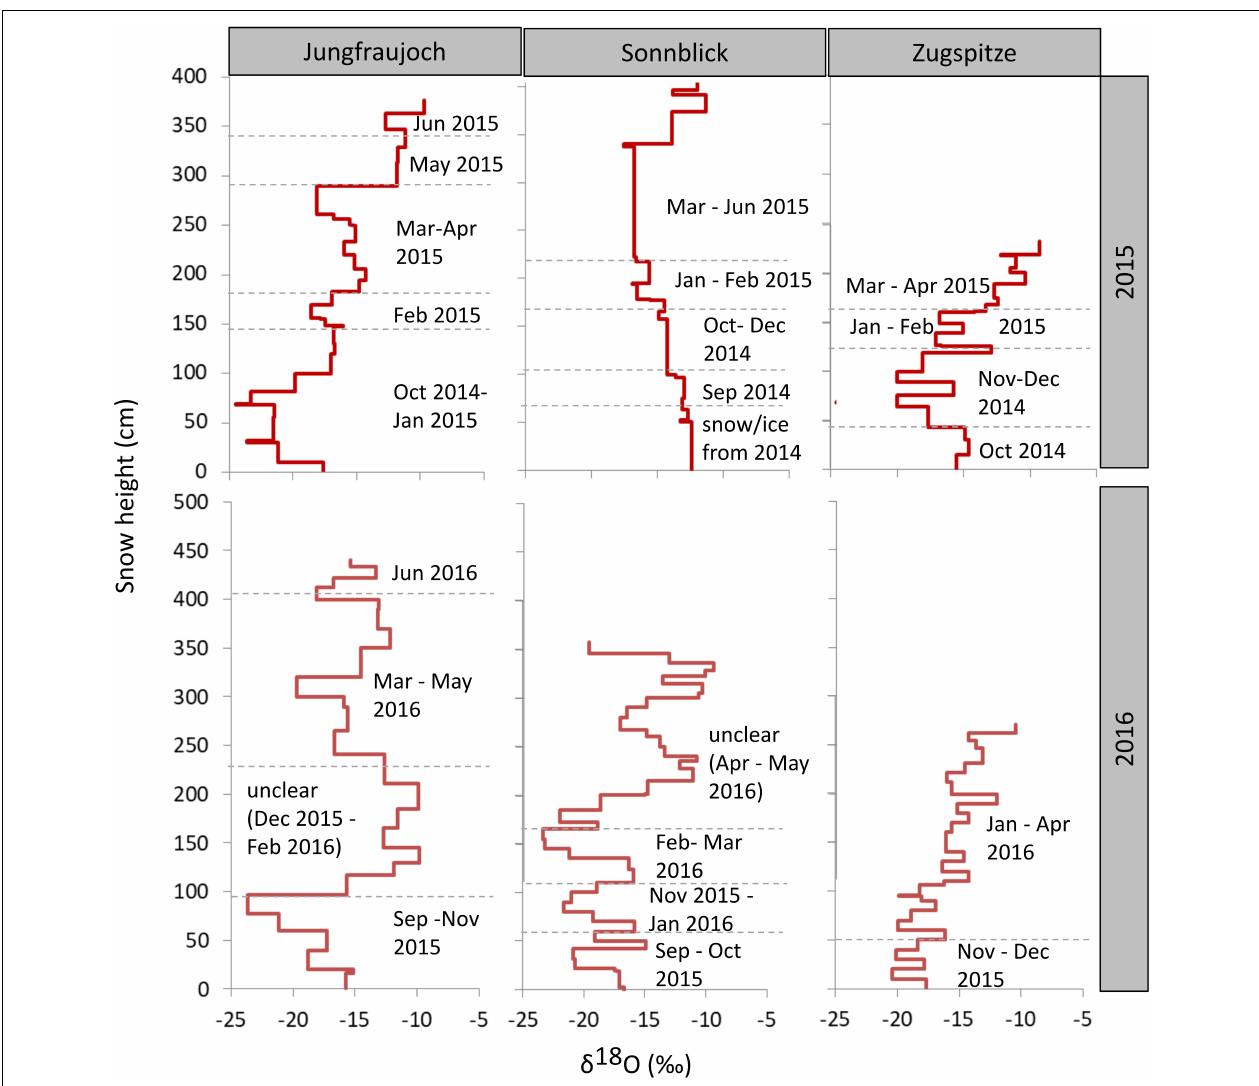
FIGURE 4 | δ 18 O values across the snowpack profiles per site and year. Times of accumulation periods were approximated by considering isotope ratios in precipitation during the accumulation period as well as precipitation amount and snow water equivalents. Height of the snow layer is given in cm above the bottom of the